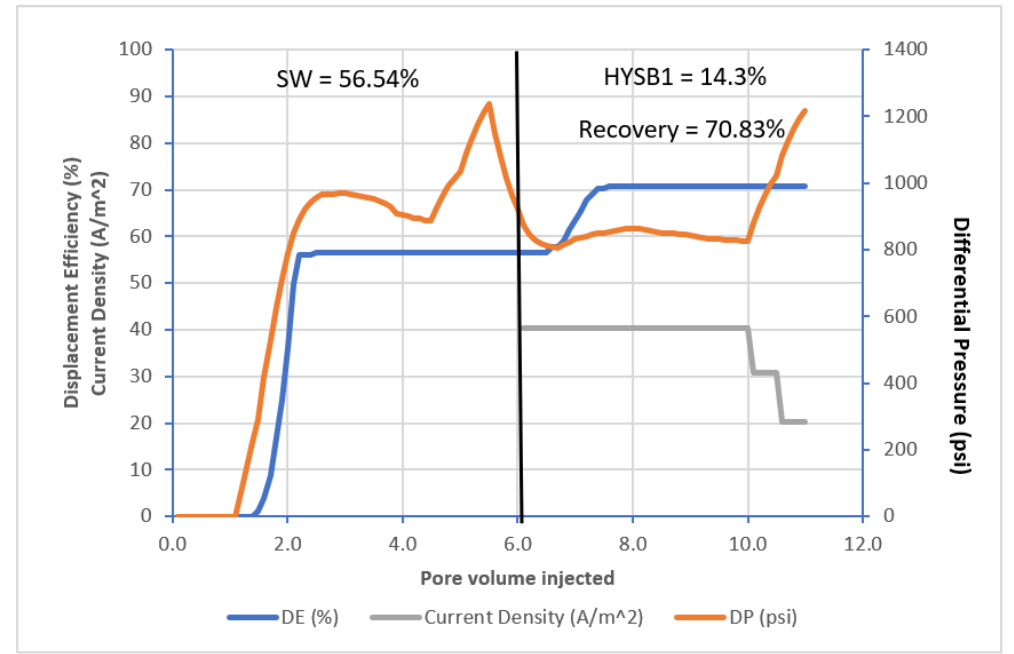
Figure 14. DE, DP (ΔP), Current Density vs. Pore Volume Injected for CF12 . Figure 14. DE, DP ( ∆ P), Current Density vs. Pore Volume Injected for